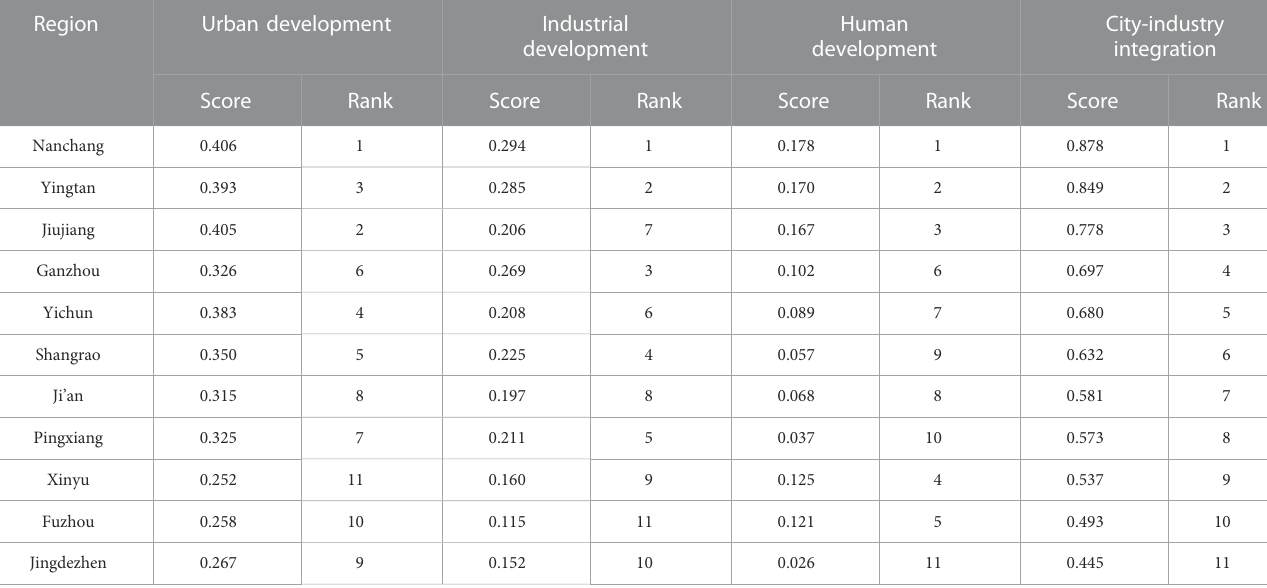
TABLE 2 Evaluation degree of city-industry integration in Jiangxi Province. Region Urban